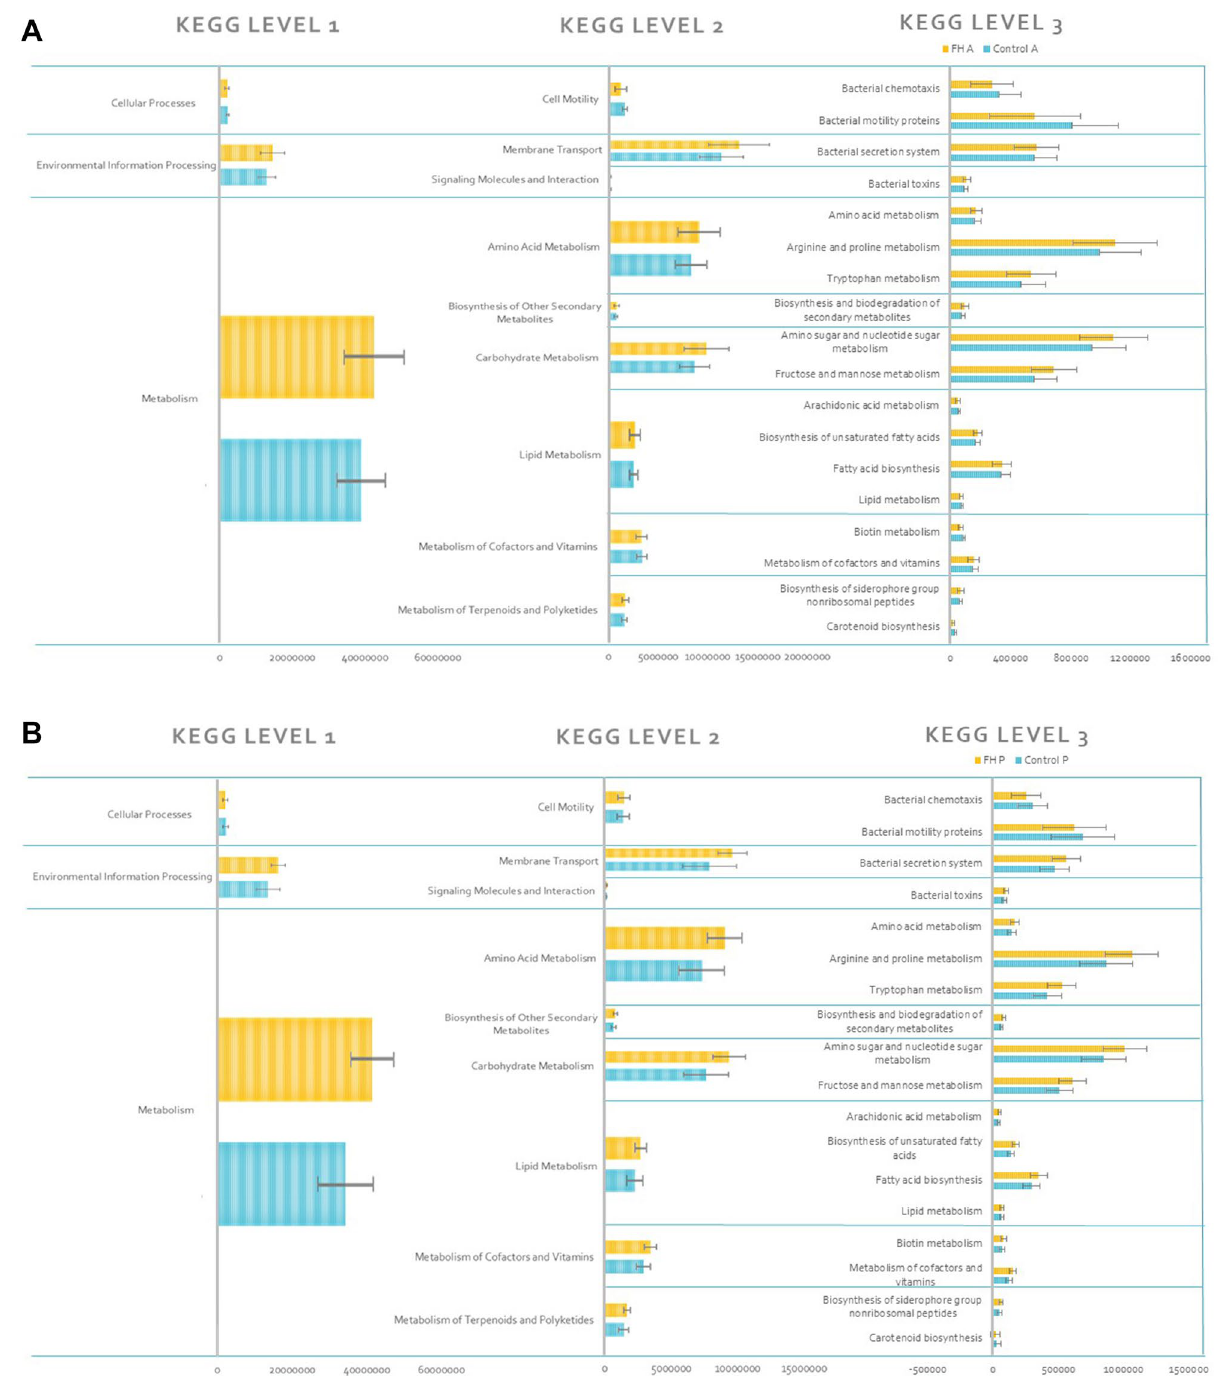
Figure 6. PICRUSt predictions of the functional composition of S. aurata gut microbiota. ( A ) Represents KEGG pathway at level 1,2 and 3, in anterior section and ( B ) in posterior section. Blue and yellow bars make reference to Control and FH diets,